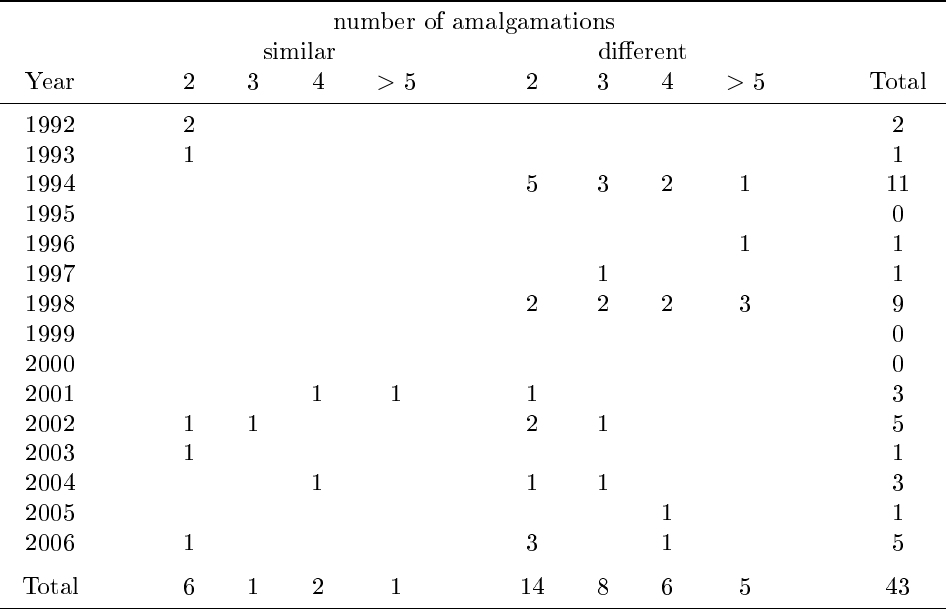
Table 1: Varying number of municipal amalgamations number of amalgamations similar